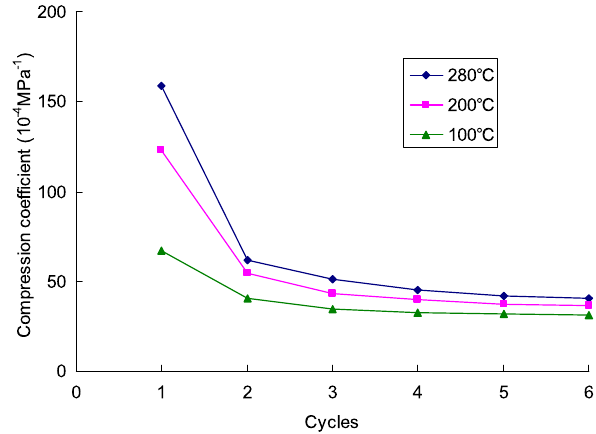
Fig. 8 Impacts of temperature on the compression coefficient experiencing temperature cycles (the effective confining pressure is 9 MPa)